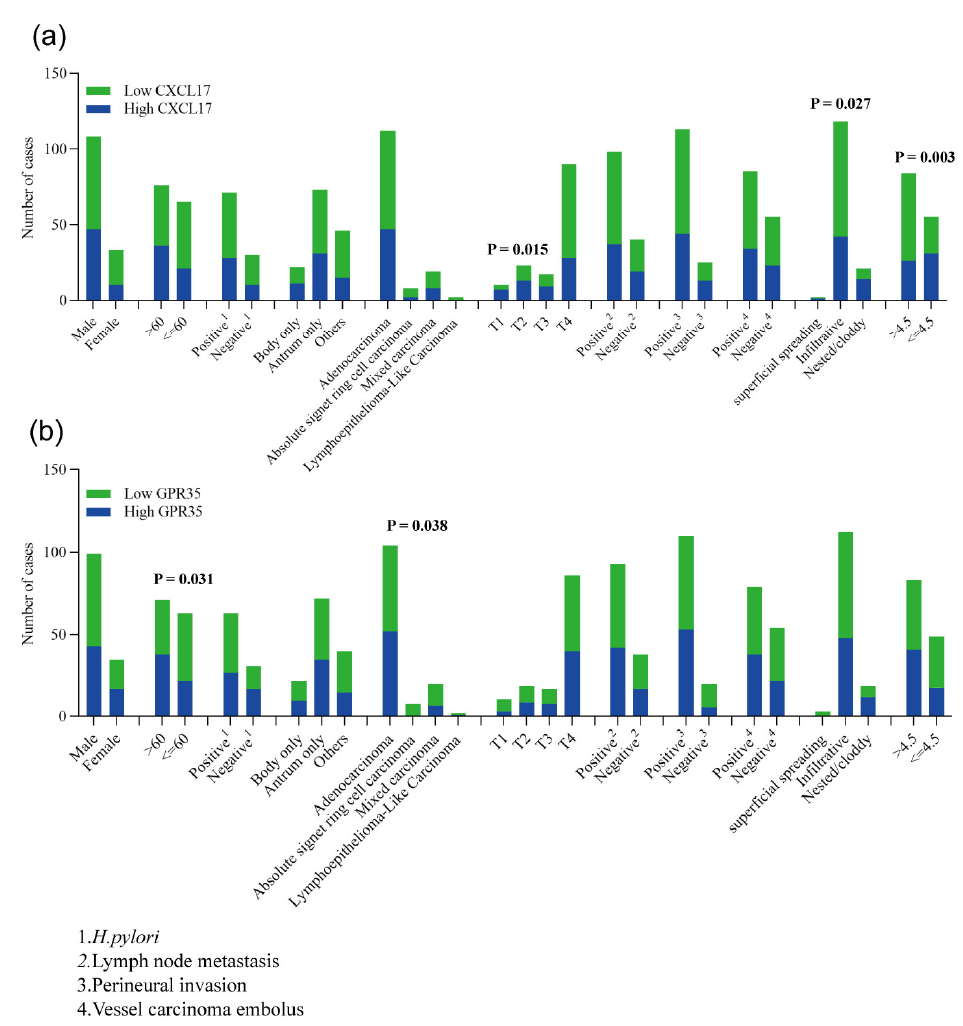
Figure 3. Associations of CXCL17 ( a ) and GPR35 ( b ) with clinical parameters. 2.3. The Clinical Value of CXCL17 and GPR35 in Predicting GC Prognosis Overall, 111 and 103 GC cases with available overall survival (OS) information were included for survival analysis in the CXCL17 and GPR35 groups, respectively. Patients with high CXCL17 expression had better survival in comparison to those with low expression (median OS: not reached vs. 31 months; log-rank p = 0.031) (Figure 4a). The median OS of patients with high GPR35 expression was 42 months, which was longer than the 36 months for the low GPR35 expression group, though the difference was not significant ( p = 0.616) (Figure 4b). The multivariate survival analysis suggested that the high expression of CXCL17 served as an independent biomarker of favorable prognosis in GC patients ( p = 0.027; HR = 0.484, 95%CI = 0.255–0.919) (Figure